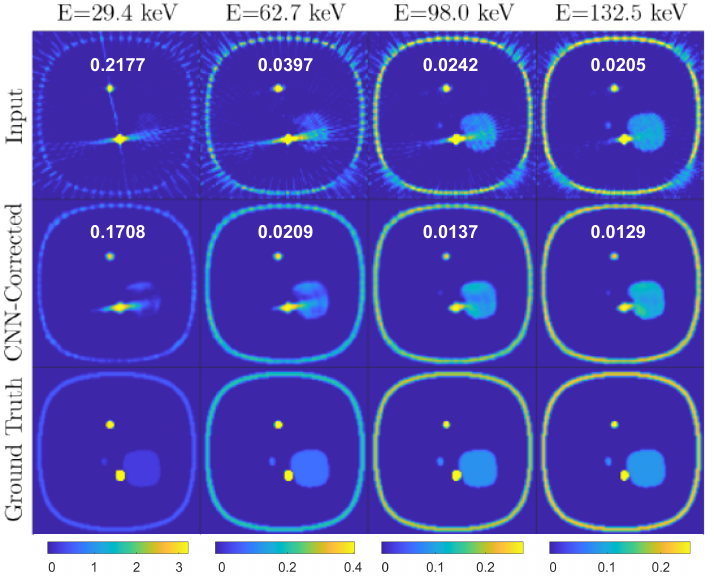
Figure 7. Simulation test data. Example 3: the object features are only partially corrected by the CNN architecture due to severe artifacts. (Layout as in Figure